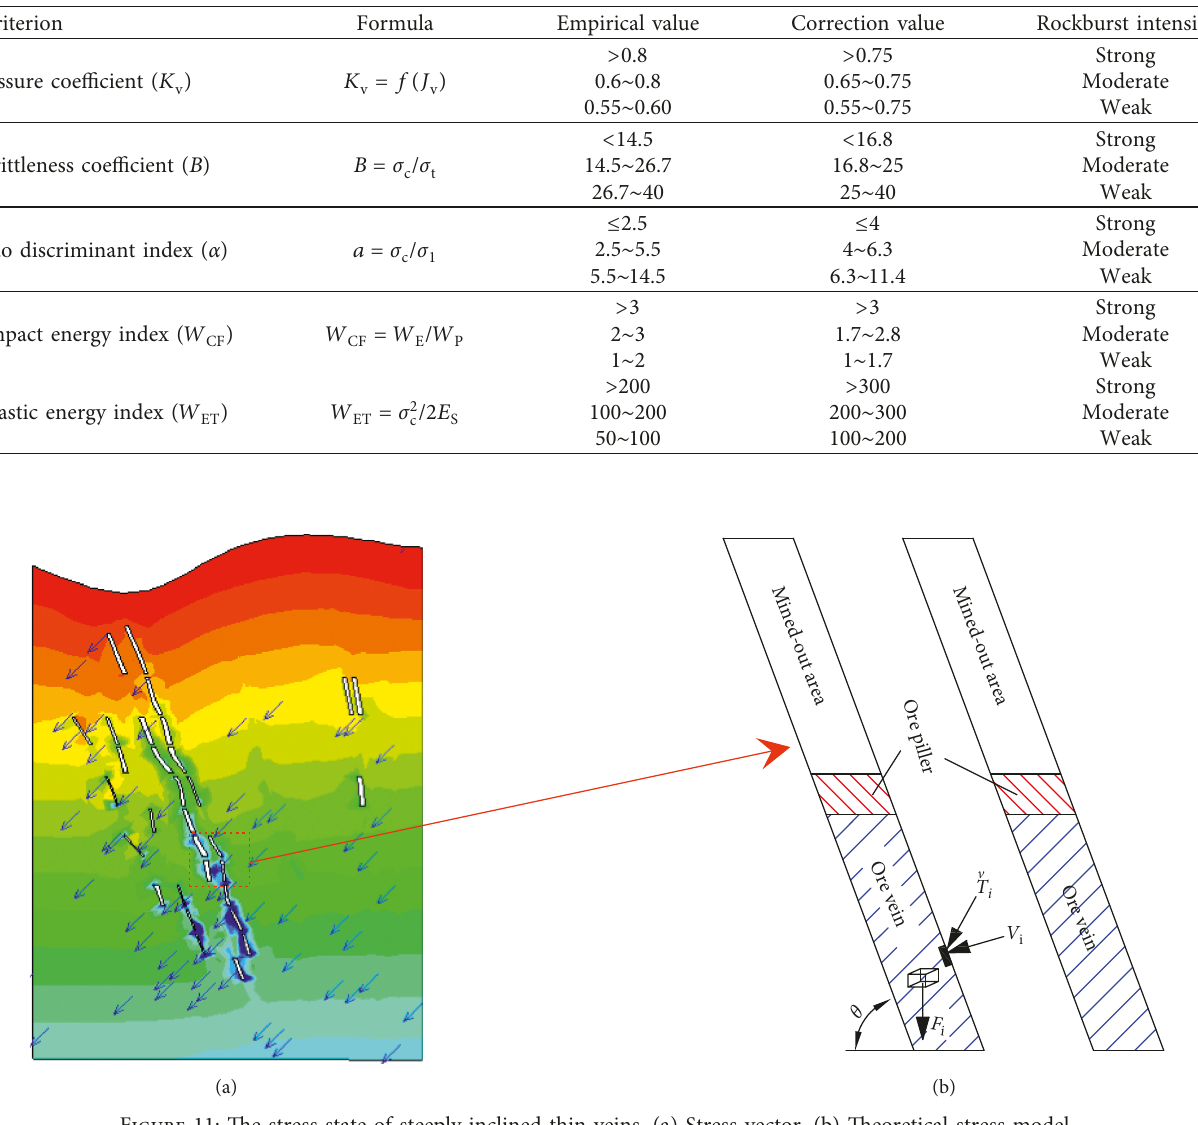
Figure 11: The stress state of steeply inclined thin veins. (a) Stress vector. (b) Theoretical stress